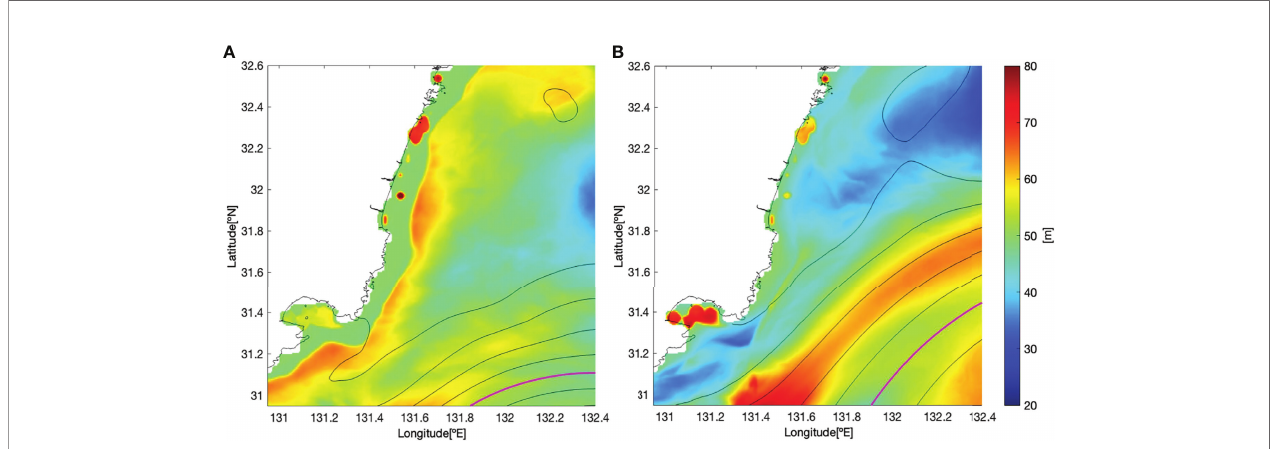
FIGURE 12 | Monthly averaged model mixed layer depth (m), where the density difference is 0.125 kg m -3 from the surface, for (A) November and (B) December. Black contours represent monthly mean SSH and magenta line represents the monthly mean model Kuroshio axis at SSH = 0.2